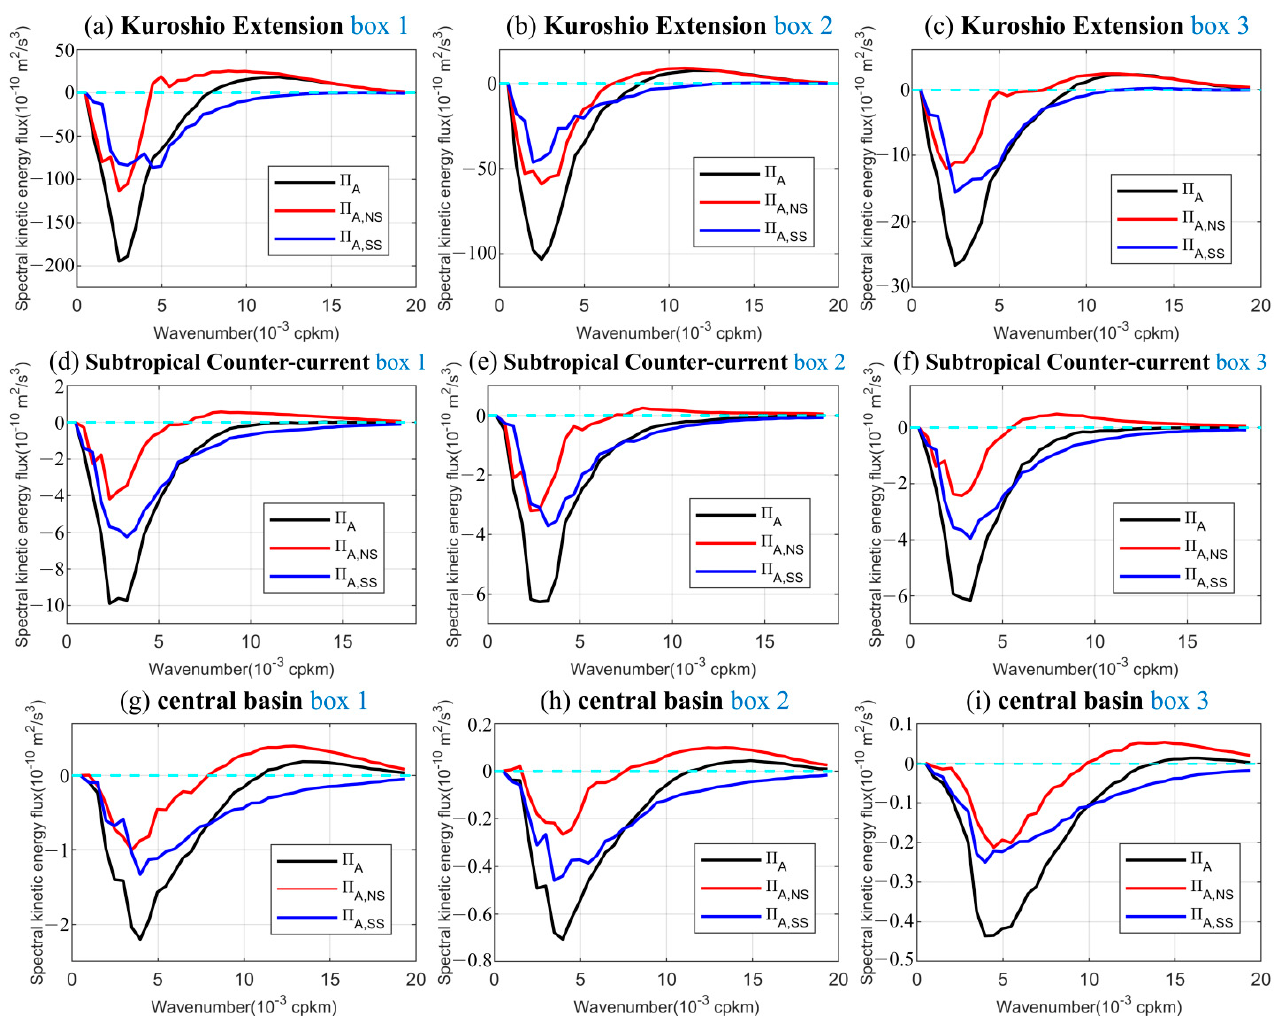
Figure 9. Time-mean of the total, normal-strain [ Π A, NS , Equation (24)], and shear-strain [ Π A, SS , Equation (25)] components to the spectral kinetic-energy flux Π A at a depth of 100 m in the nine regions from Figure 2. The title of each panel indicates the name of each region. No pre-processing of velocity is applied.